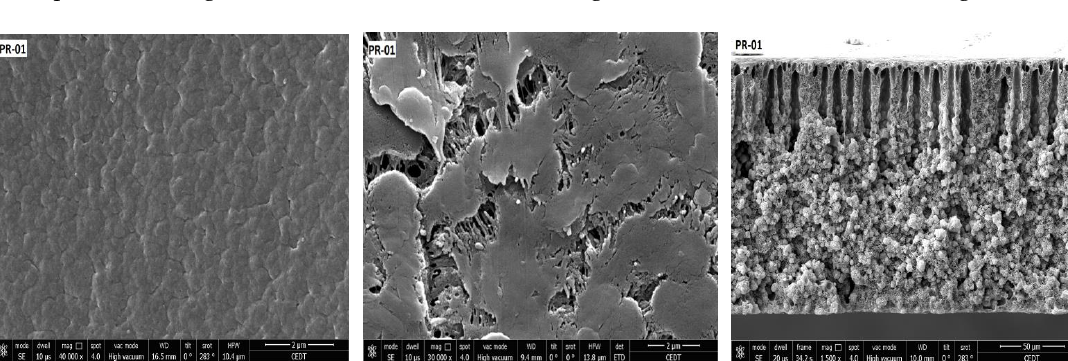
Figure 7. Effect of different solvent on blended membrane porosity.